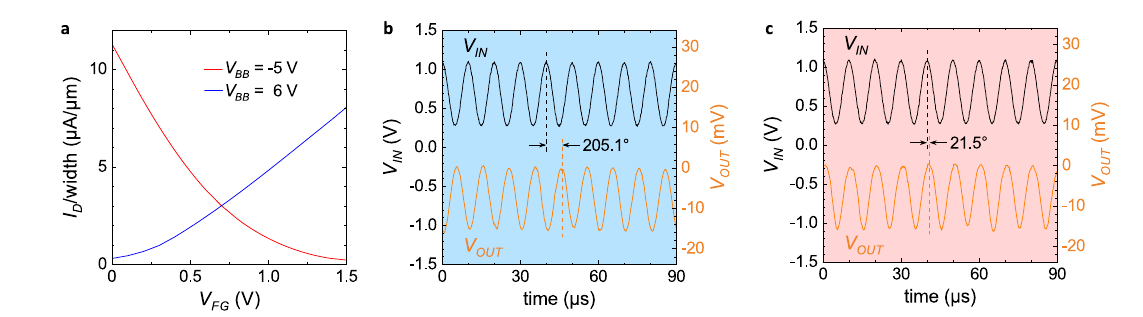
Fig. 4 | Demonstration of phase shifting and following modes, with the same BB-RFET and setup as shown in Fig. 3b. a Individual transfer characteristics showingtheunderlyingp-type(red)andn-type(blue)behaviorforvariedback-bias voltages V BB . b When the BB-RFET operates in n-con fi guration, the output signal